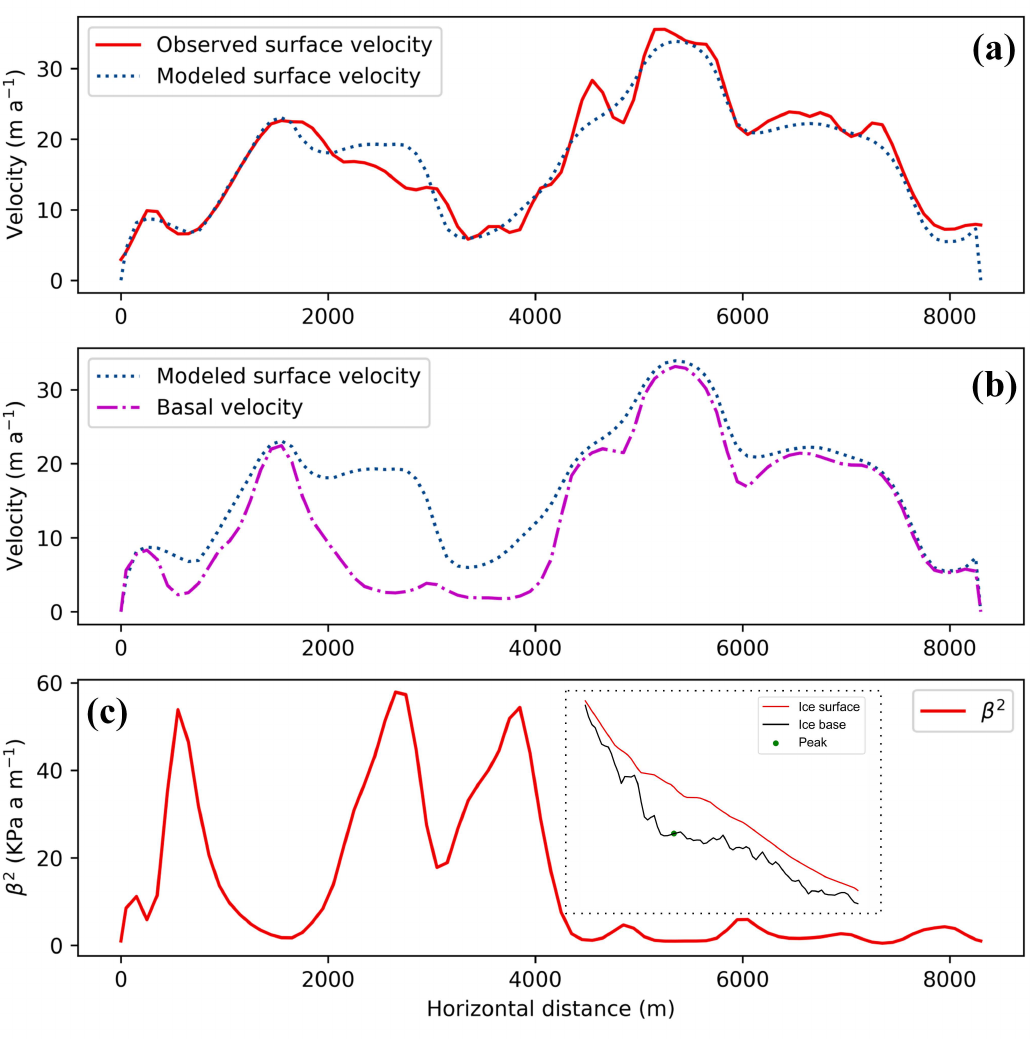
Figure 4. Robin inversion results. ( a ) Surface flow velocity (the red solid line indicates the calibrated ITS_LIVE velocity, and the blue dotted line indicates the modeled velocity). ( b ) Simulated surface velocity versus sliding velocity (the blue dotted line indicates the modeled surface velocity, and the magenta dash-dotted line represents the modeled sliding velocity). ( c ) The basal friction coefficient obtained by inversion, the inset shows the peak areas of the basal shear